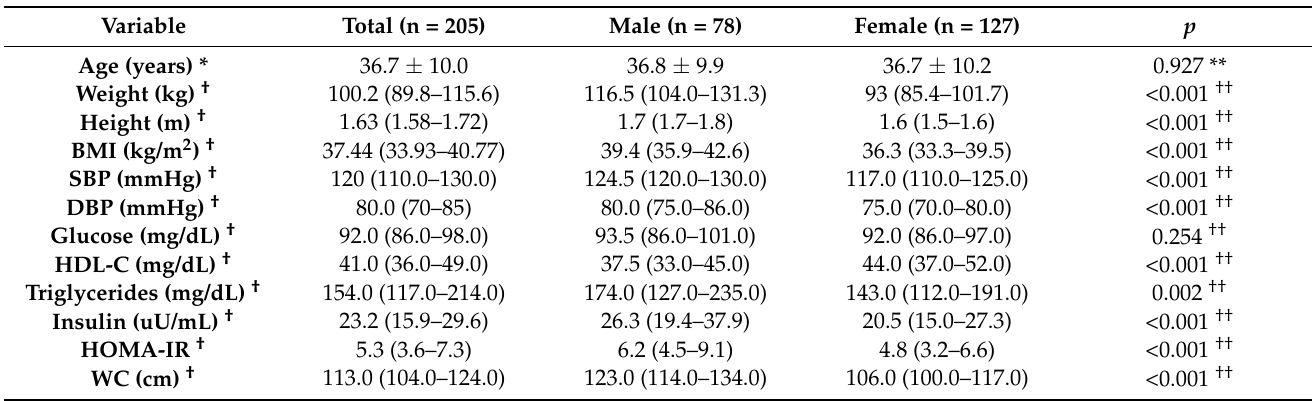
Table 2. Sociodemographic data and components of metabolic